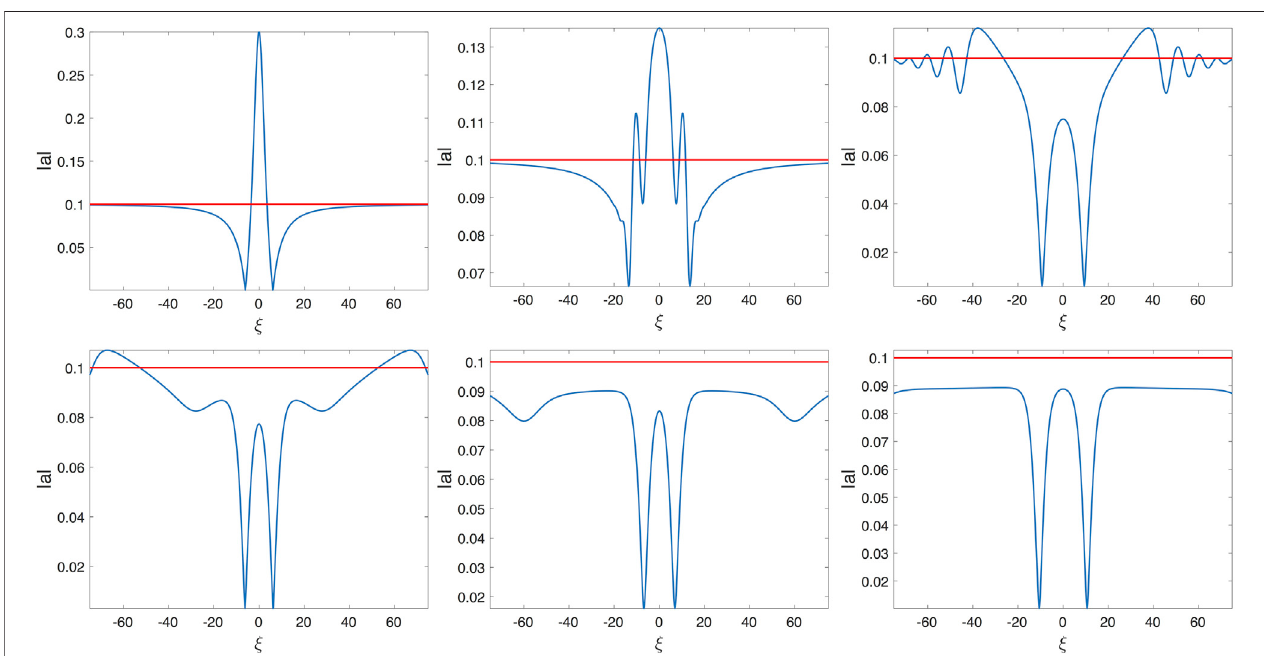
FIGURE 3 | Time evolution of the tranformation of the Peregrine breather into a two-grey soliton with g (cid:2) 1 and k (cid:2) 1. Top panels from left to right: τ (cid:2) 0 , 23 T , 145 T . Bottom panels from left to right: τ (cid:2) 298 T , 596 T , 901 T . T is the period of the Peregrine breather background.